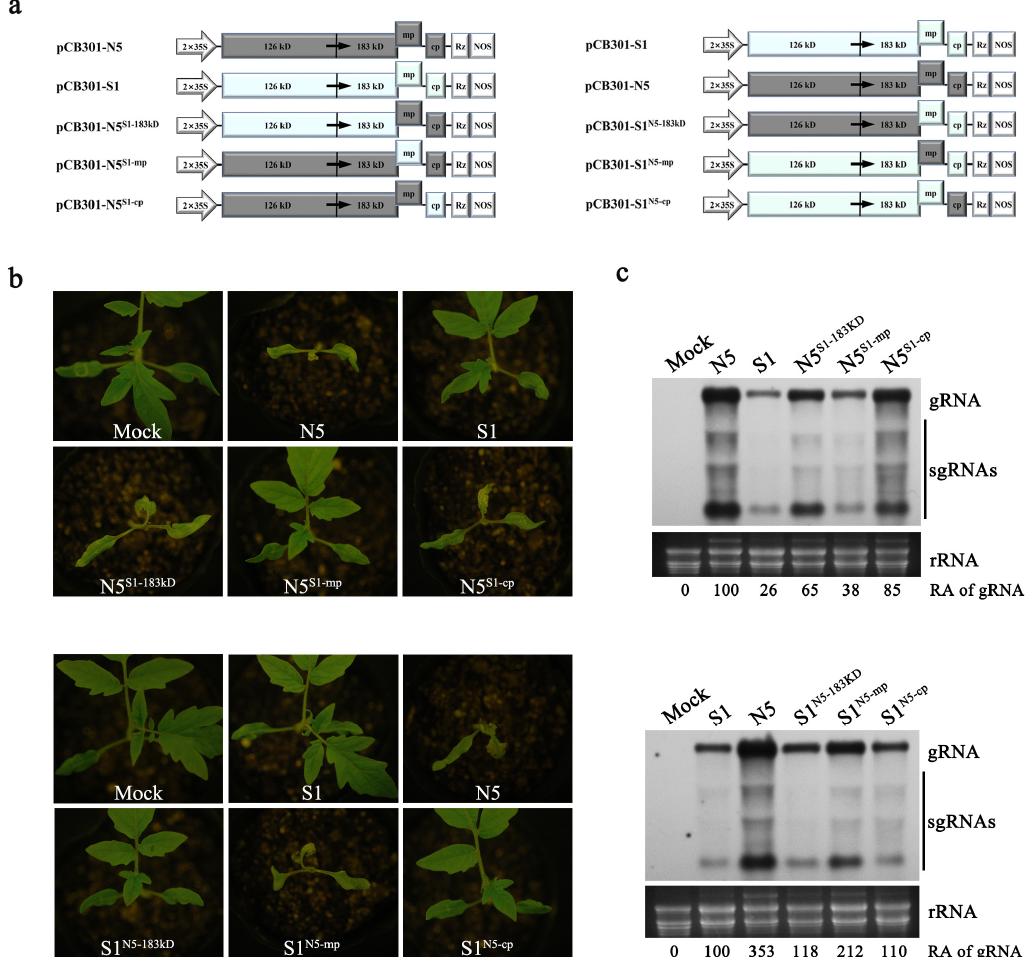
Figure 1. Genetic mapping of the viral protein responsible for the induction of systemic necrosis in tomato plants with infection of ToMV-N5. ( a ) Schematic diagrams of the 35S promoter-based infectious clones of wildtype N5 and S1 strains of ToMV, and their derivatives. The DNA fragments of viral genomes were inserted between the 35S promoter (2 × 35S) and HDV cis-cleaving ribozyme sequence (Rz) in the binary vector pCB301. Viral sequences of N5 and S1 are colored gray and light blue, respectively. Six chimeric viruses expressing heterologous 183 KD protein, MP, or CP were shown. For instance, pCB301-N5S1-183KD is the construct where the 183 KD in N5 was replaced with that of S1, and pCB301-S1N5-183KD is the construct where the 183 KD in S1 was replaced with that of N5. ( b ) Viral symptoms on the tomato plants inoculated with N5, S1, or their chimeric viruses, as illustrated in ( a ). Plants were photographed at 7 days post-infiltration (dpi). ( c ) Northern blotting analyses of viral RNAs in the upper systematic leaves of the infected plants at 7 dpi. Viral RNAs were detected with a digoxigenin (DIG)-labeled DNA oligonucleotide complementary to the sequence of ToMV genomic 3 ′ untranslated region (3 ′ UTR). Genomic RNAs and subgenomic RNAs of these viruses were indicated with gRNA and sgRNA, respectively, to the right. Relative accumulation levels of gRNA were shown below. Ethidium bromide (EB)-stained ribosomal RNAs (rRNAs) were used to indicate the relative amounts of RNA samples loaded.